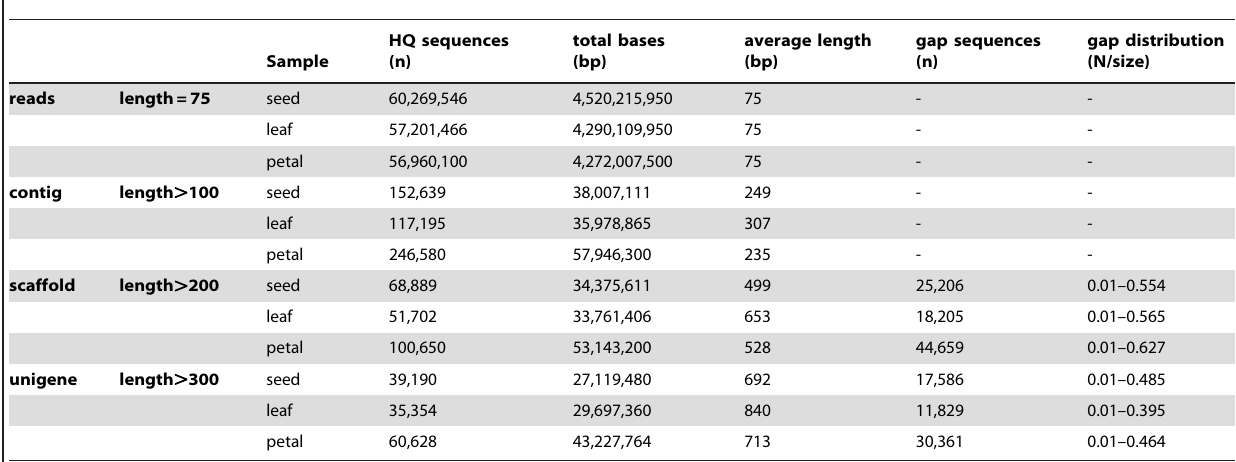
Table 1. The summary of sequencing and assembling